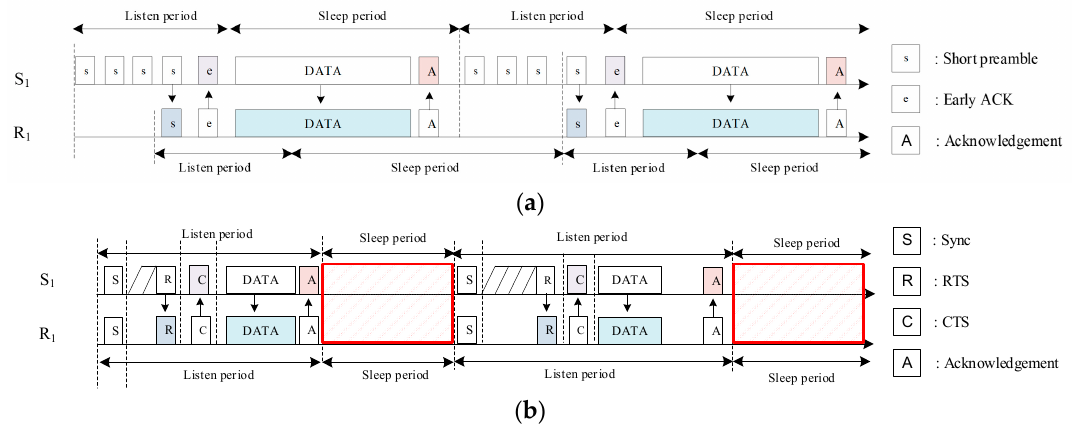
Figure 1. Duty-cycle-based protocol operation methods: ( a ) X-MAC protocol; ( b ) S-MAC protocol.